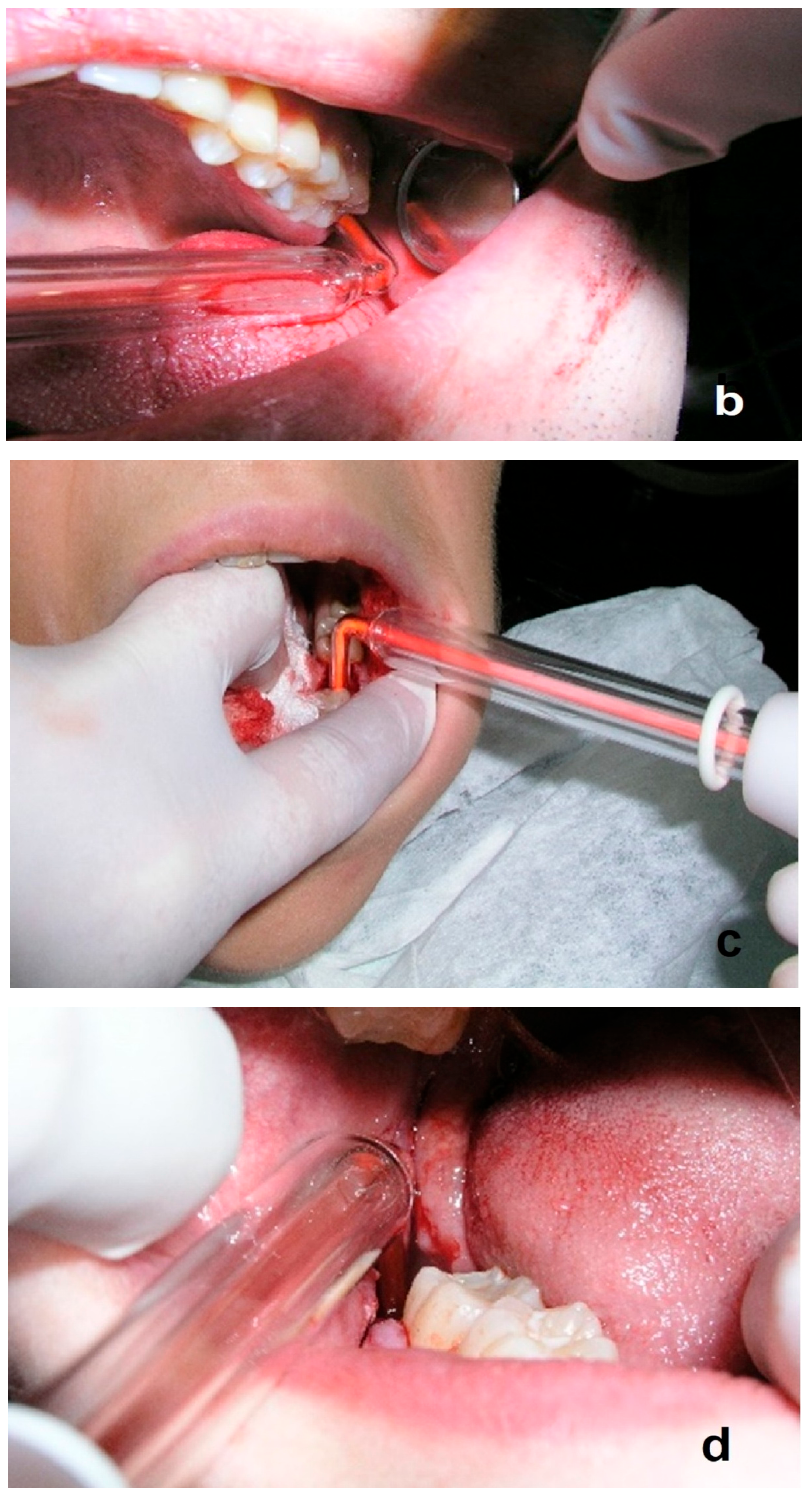
Figure 6. Application of ozone therapy prophylactically before treatment ( a ) and immediately after treatment ( b – d ). The glass probe of the OzonyTron ozone generator (Mymed) was used (authors’ own photographic documentation).